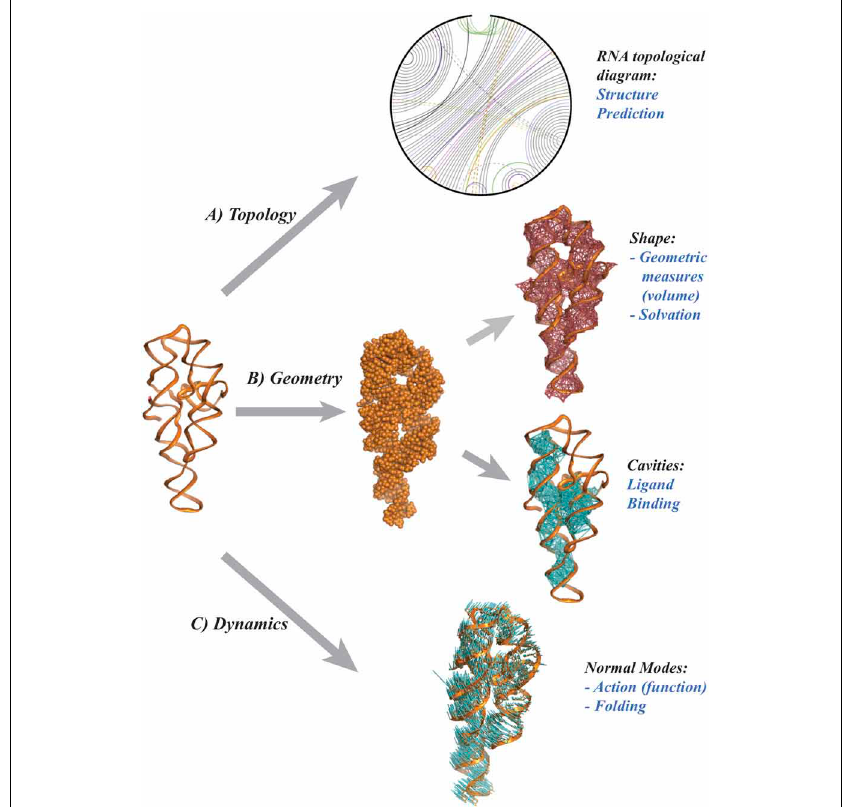
FIGURE 1 | Topology and Geometry of RNA molecules. From a pure chemical point of view, a RNA molecule is a polymer of nucleotide residues, The cartoon on the left illustrates the backbone of the P4-P6 group I rybozyme of tetrahymena thermophila (Cate et al., 1996). Each nucleotide includes one base. There are four main types of bases, A, U, G, and C that may form pairs, with a strong preference for the pairs A-U and G-C. (A) a diagram representing the RNA as an open circle, with edges representing the base pairs. The presence of crossing edges indicates topological constraints in the RNA. (B) The shape of the RNA may be characterized as a union of balls, with one ball per atom, whose geometry can be characterized using the alpha shape theory (Edelsbrunner and Koehl, 2005) . (C) The atomic displacements corresponding to the normal mode with lowest frequency are shown as (blue) line segments. Panel (A) was drawn using RNA 3D Hub (http://rna.bgsu.edu/rna3dhub), and panels (B,C) are drawn with Pymol